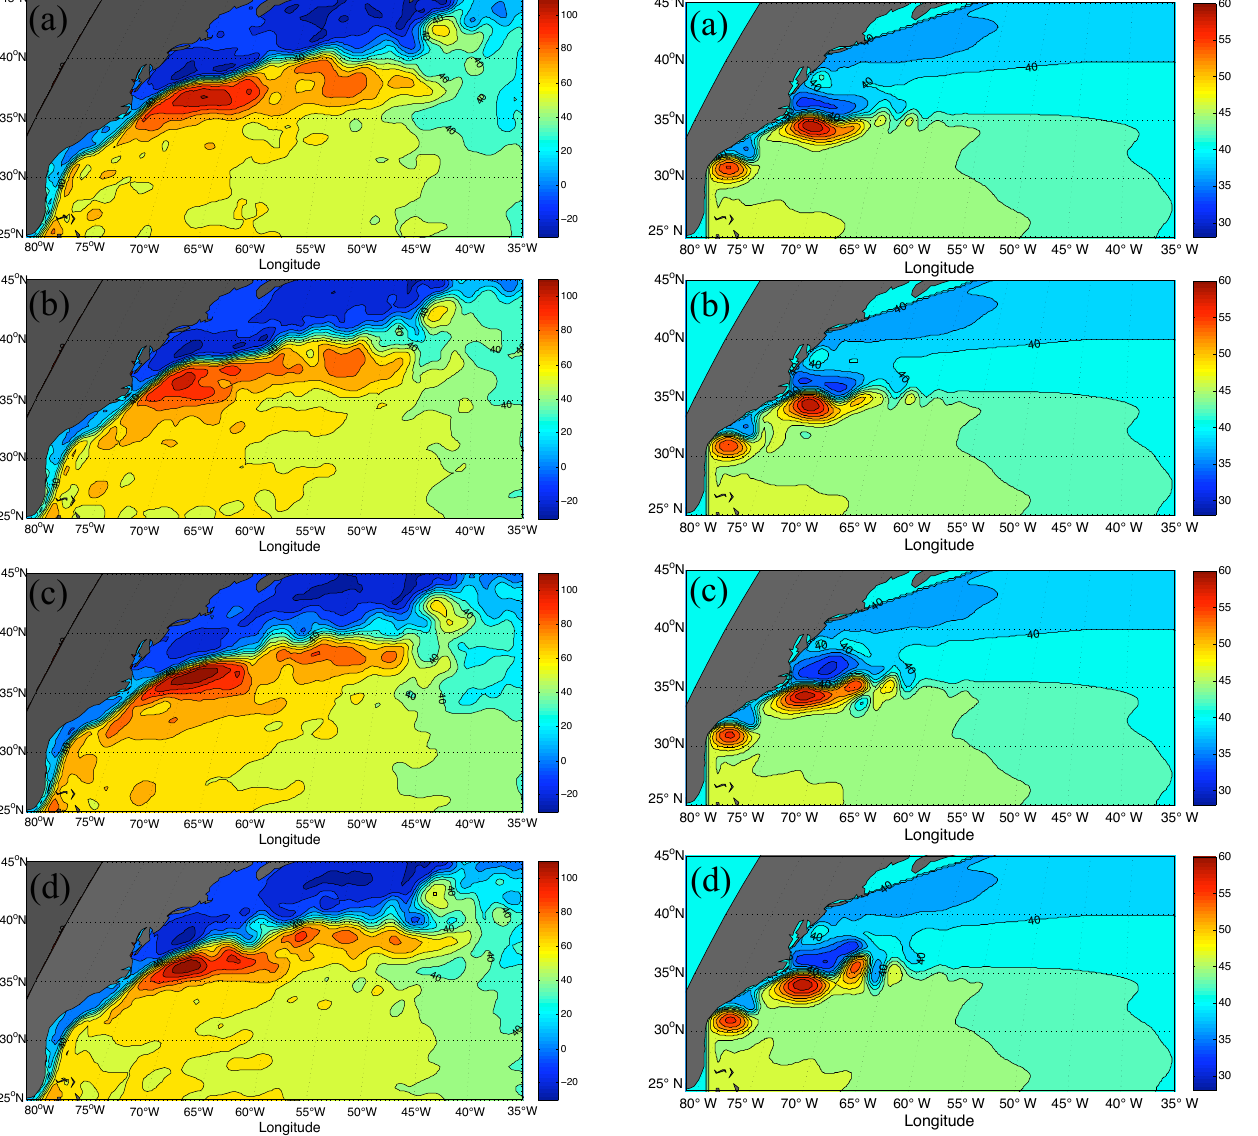
Fig. 7. Annual averages of the absolute dynamic topography dis- tributed by Aviso/Cnes (cm). From top to bottom: year 1995, 2000, 1998, 2006.